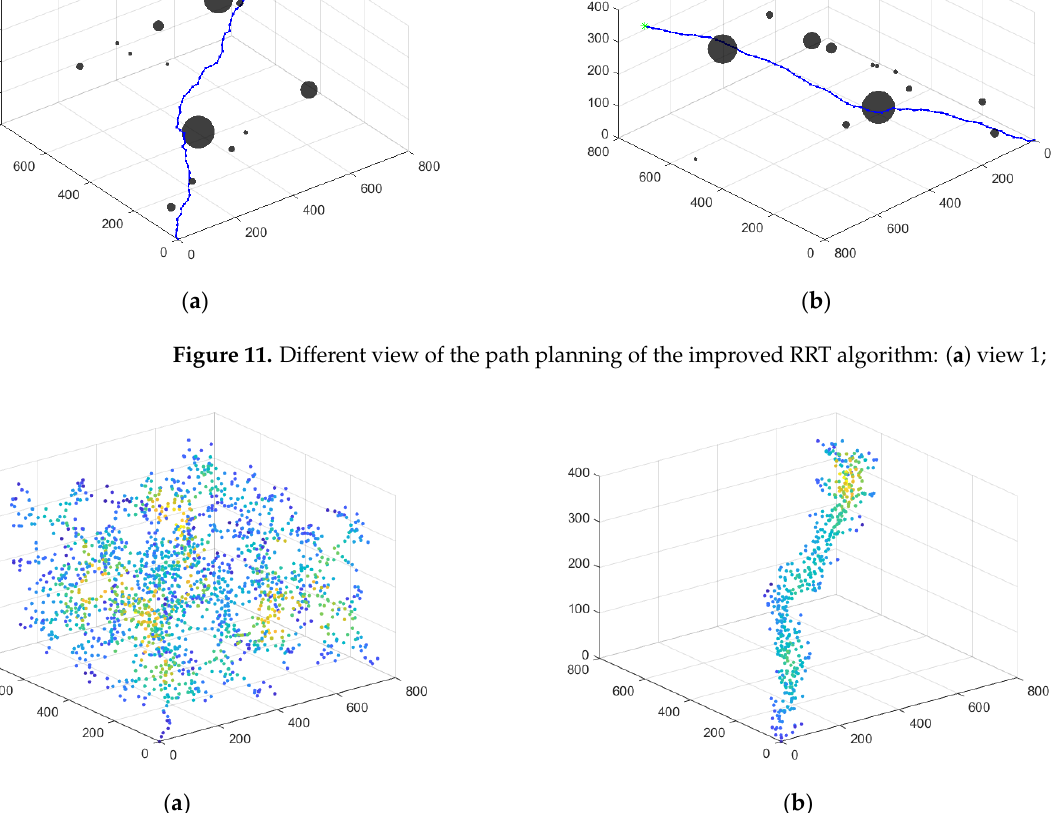
Figure 12. A comparison of all nodes generated by the improved RRT algorithm and the conventional RRT algorithm: ( a ) nodes generated by the conventional RRT algorithm; ( b ) nodes generated by the improved RRT algorithm. The brighter the color in the picture, the denser the nodes.